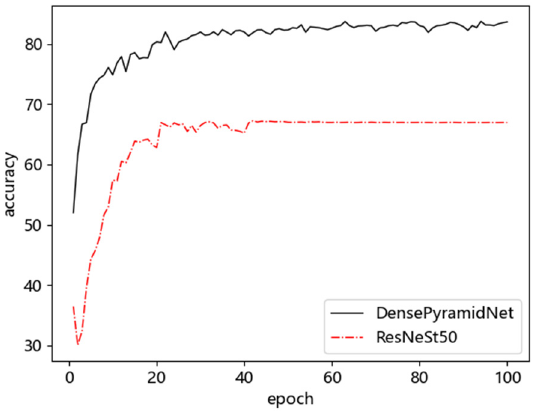
Figure 14. Comparison with ResNeSt50 in cifar10 test accuracy.